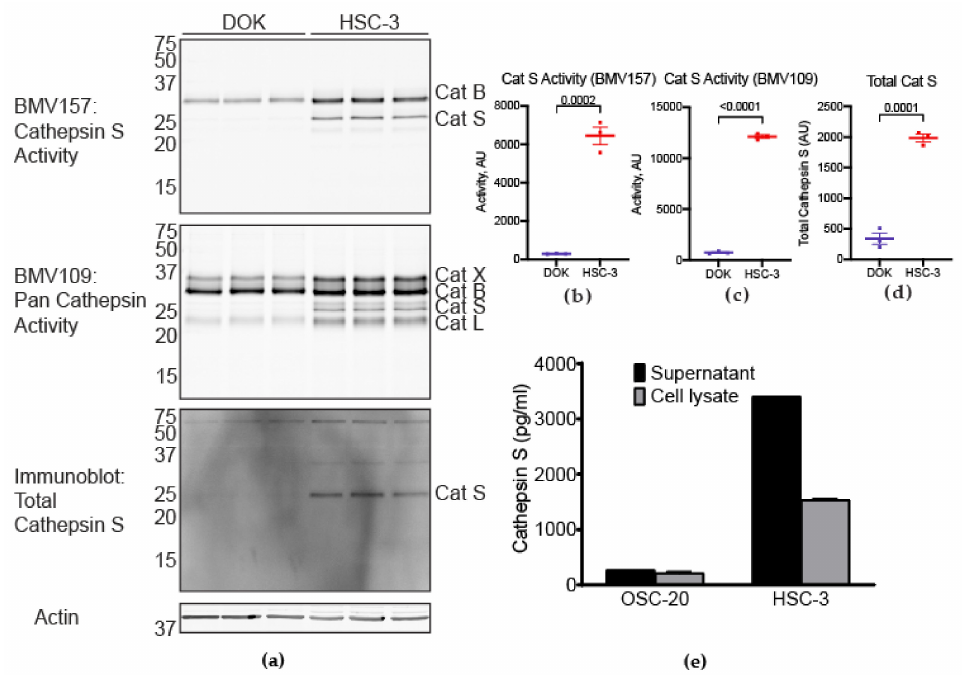
Figure 6. Cathepsin S activity and expression are increased in human oral cancer cells. Cathepsin S activity was compared between HSC-3 and the human dysplastic oral keratinocyte cell line, DOK. ( a ) Labeling of cathepsin S activity with BMV157 selective for cathepsin S in DOK and HSC-3, as shown by in-gel fluorescence; immunoblots confirmed cathepsin S. Labeling of pan cathepsin activity with BMV109 in DOK and HSC-3; immunoblots confirmed cathepsin X, B, S and L; cathepsin S activity is significantly higher in HSC-3 compared to DOK as measured by ( b ) BMV157, and ( c ) BMV 109. The uncropped western blot figure is presented in Figure S3. ( d ) Total cathepsin S activity in HSC-3 is significantly higher than in DOK. ( e ) ELISA assay to measure cathepsin S in supernatant and whole-cell lysate from HSC-3 and a second human oral squamous cell line,